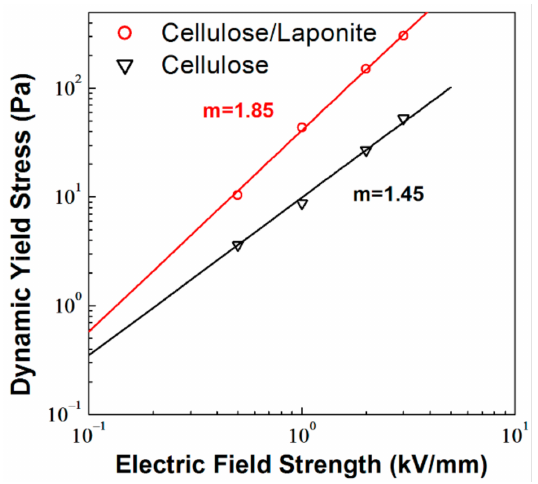
Figure 5. Dynamic yield stress ( τ y ) of the ER fluids as a function of electric field strength ( E ). The solid lines are fitted from the power law equation τ y ∝ E m